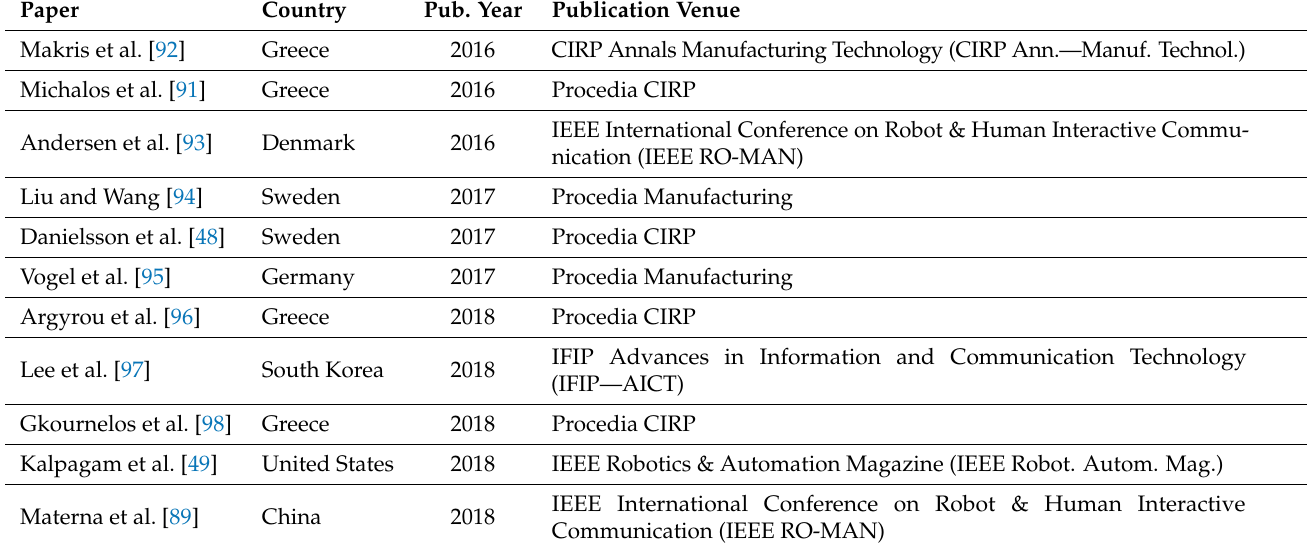
Table 7. Papers assessment and general